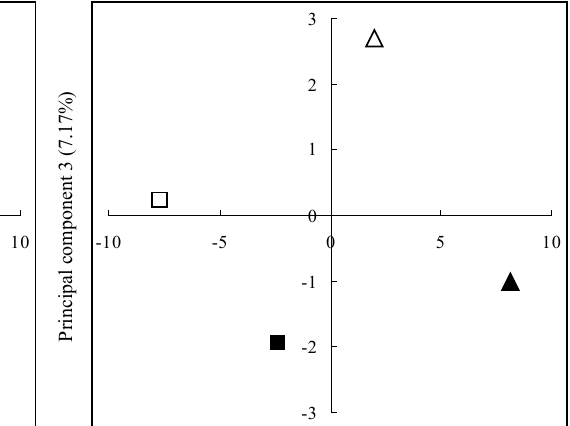
of each type number to total number of detected substances in hot-water extract Fig. 1: Proportion of tea